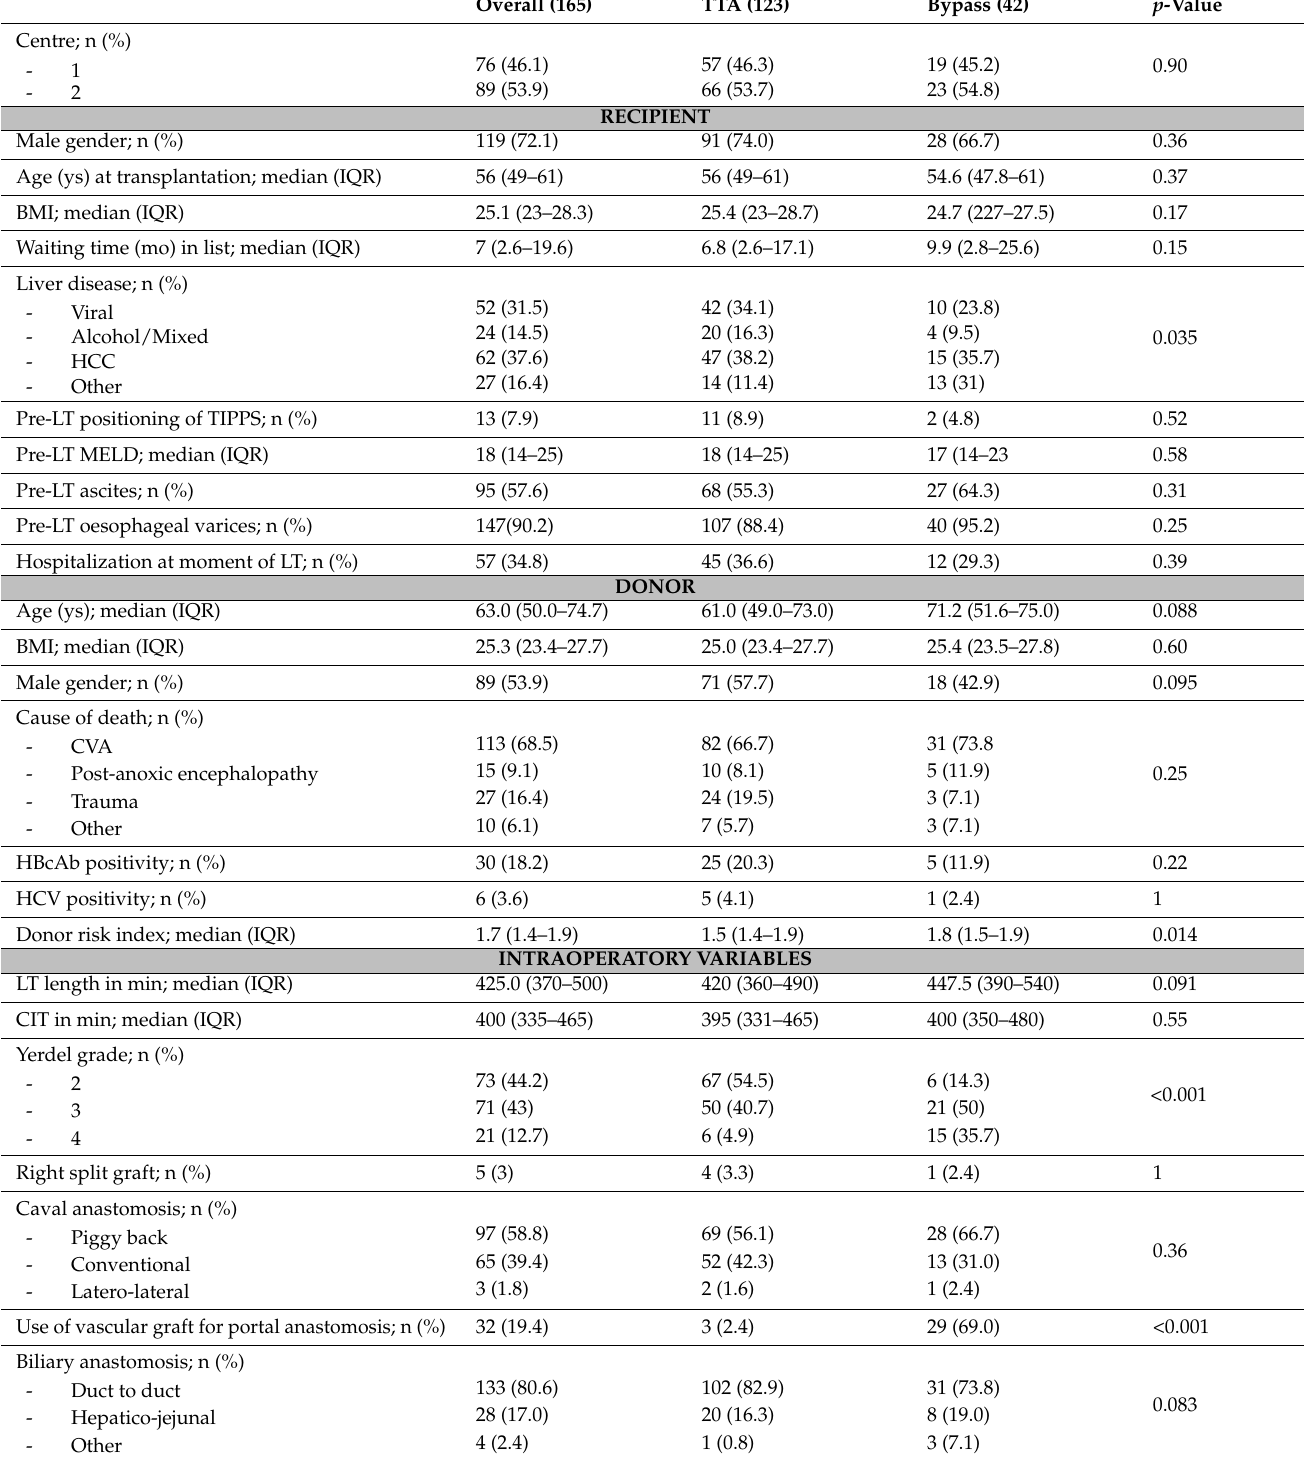
Table 1. Preoperative clinical features of the recipient, donor and intraoperative data compared between the two groups of portal reconstruction (TTA versus Bypass). Univariate